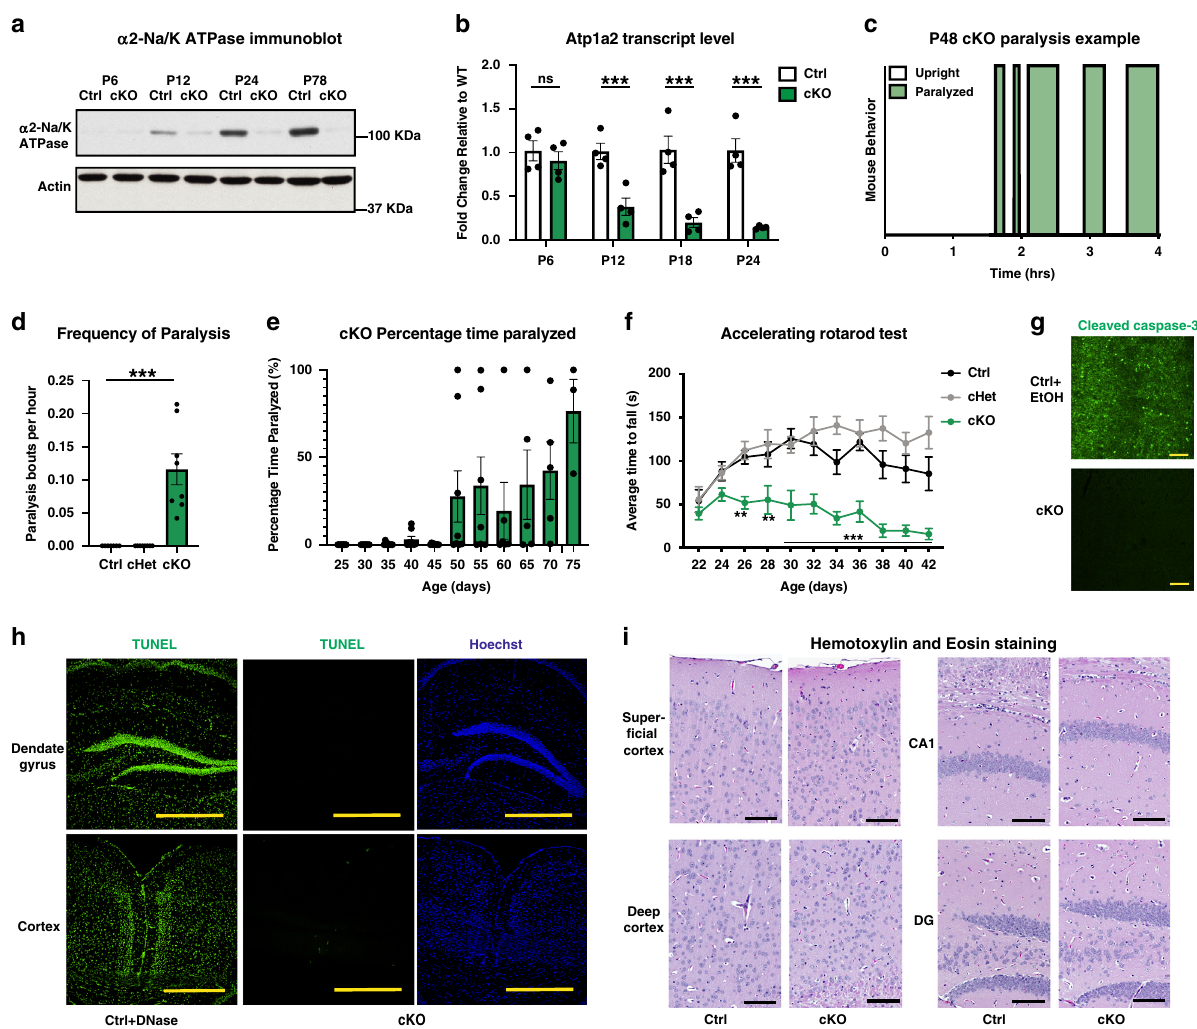
Fig. 1 Conditional α 2-Na/K ATPase knockout mice display spontaneous transient paralysis. a Lysates of the cerebral cortex from P6, P12, P24, and P78 conditional α 2-Na/K ATPase knockout (cKO) and sex-matched littermate f/f or f/ + control (Ctrl) mice were immunoblotted with α 2-Na/K ATPase and actin antibodies, the latter serving as loading control ( n = 3 mice per group, quanti fi cation in Supplementary Fig. 2, full blots in Supplementary Fig. 15). b Lysates of the cerebral cortex from cKO or Ctrl mice at each age were subjected to qRT-PCR analyses using primers to α 2-Na/K ATPase, normalized to Gapdh. Gapdh levels did not differ between groups (Supplementary Fig. 14a). Data are presented as mean ± s.e.m. *** P < 0.001 (two-way ANOVA followed by Fisher ’ s LSD post hoc test). c – e cKO, Ctrl, and conditional α 2-Na/K ATPase heterozygous (cHet) mice were subjected to paralysis video monitoring. A representative trace from a P48 cKO mouse is shown ( c ). Shaded green regions represent paralysis. Quanti fi cation of video monitoring from conditional cKO, Ctrl, and cHet showing number of paralysis bouts ( d ). Note that no cHet/Ctrl mice ever exhibited an episode of paralysis. Data are presented as mean ± s.e.m. *** P < 0.001 (two-tailed t test, n = 7 Ctrl mice, 8 cHet mice, 8 cKO mice — 3 male, 5 female, P = 0.0005). Quanti fi cation of video monitoring from cKO mice, showing total percentage time paralyzed ( e ). Data are presented as mean ± s.e.m. ( n = 8 mice per group). f cKO, Ctrl, and cHet mice were subjected to an accelerating rotarod test. * P < 0.05, ** P < 0.01, *** P < 0.001 (two-way ANOVA followed by Fisher ’ s LSD post hoc test comparing Ctrl and cKO, n = 6 mice per group — 4 male, 2 female). g Representative images from cleaved caspase-3 staining from 50 – 75-day-old cKO and Ctrl mice. Sections from EtOH-injected Ctrl mice served as positive control. Scale bar is 100 µ m; ( n = 2). h Representative images of sections of the cerebral cortex from 50 – 75-day-old cKO and Ctrl mice subjected to TUNEL staining. DNase-treated Ctrl sections served as positive control. Scale bar is 500 µ m; ( n = 3). i Representative images from hematoxylin and eosin staining from 50 – 75-day-old cKO and Ctrl mice. Scale bar is 100 µ m; ( n =